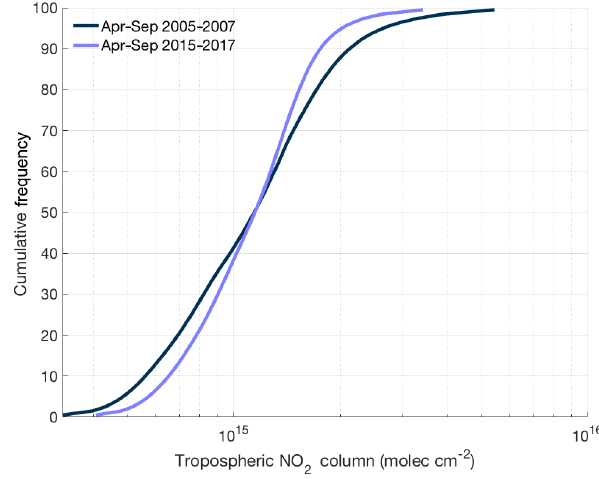
Figure 8. Cumulative frequency distribution of ozone monitoring instrument tropospheric NO 2 columns over the continental United States using the BErkeley High-Resolution (BEHR) v3.0A retrieval for summer (April–September) in 2005–2007 and